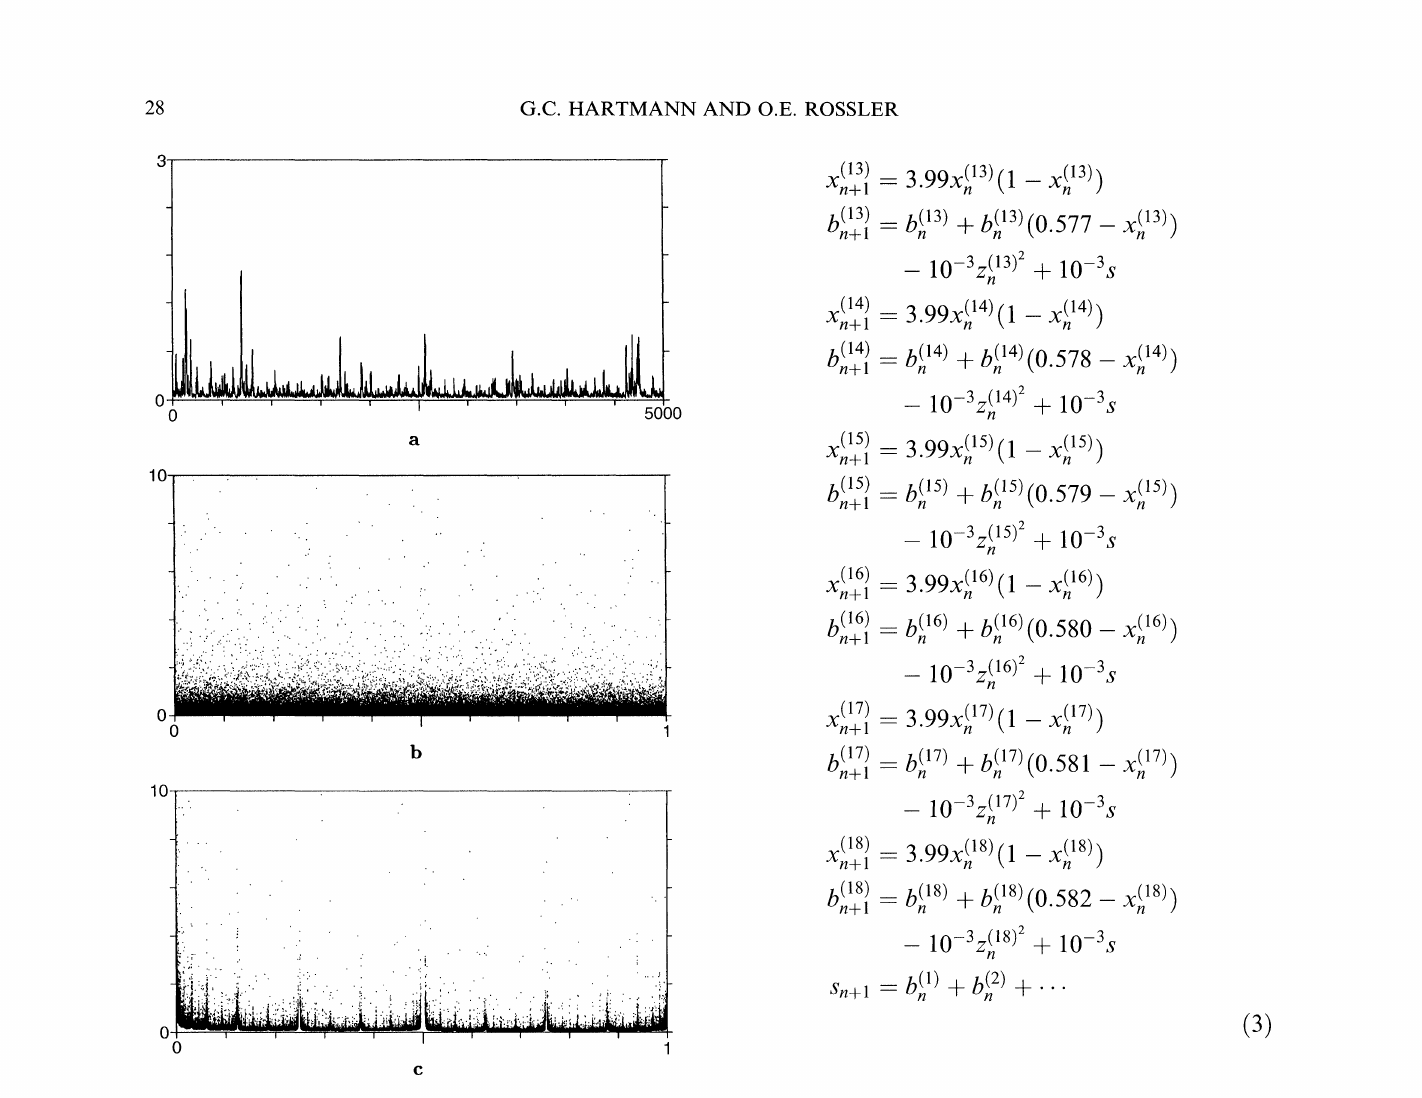
FIGURE 3 Flare attractor generated by an invertible map, Eq. (2). (a) Time behavior as in Fig. 2(a), but larger. (b) Side view (x, b plot) as in Fig. 2(b). (c) Cross-view, y, b plot. A cross section between x 0 and x is shown (note that no narrower slice is necessary with this particular map). 000 000 iterations are shown (in (b) and (c)). Initial conditions: x/, Yo 0.1, bo 0.1. tend--5000 (in x0